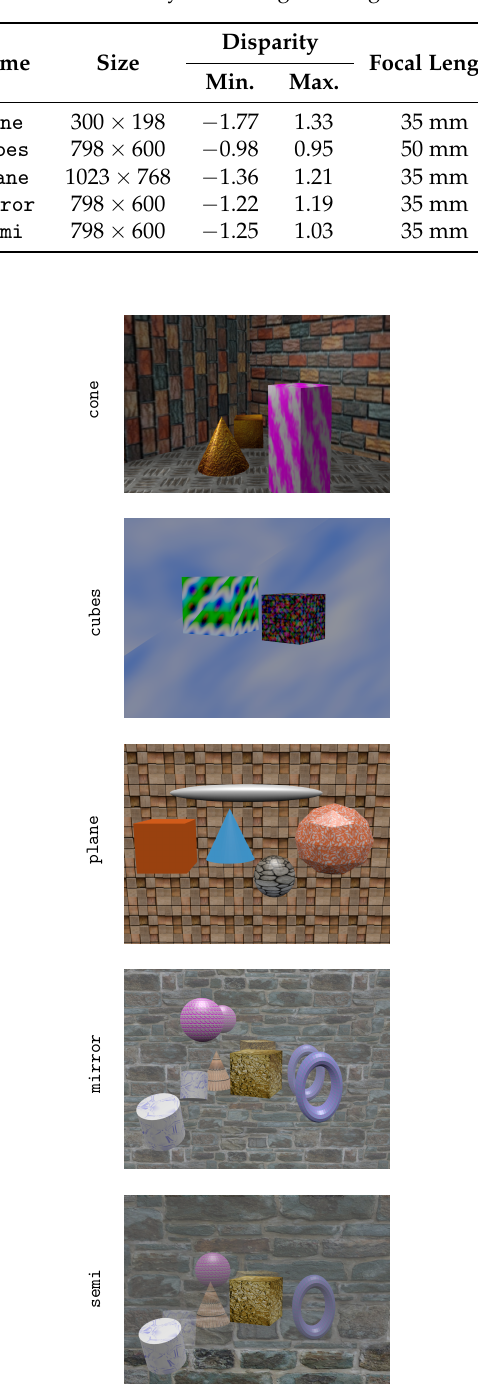
Table 4. Summary table of light-field generated.